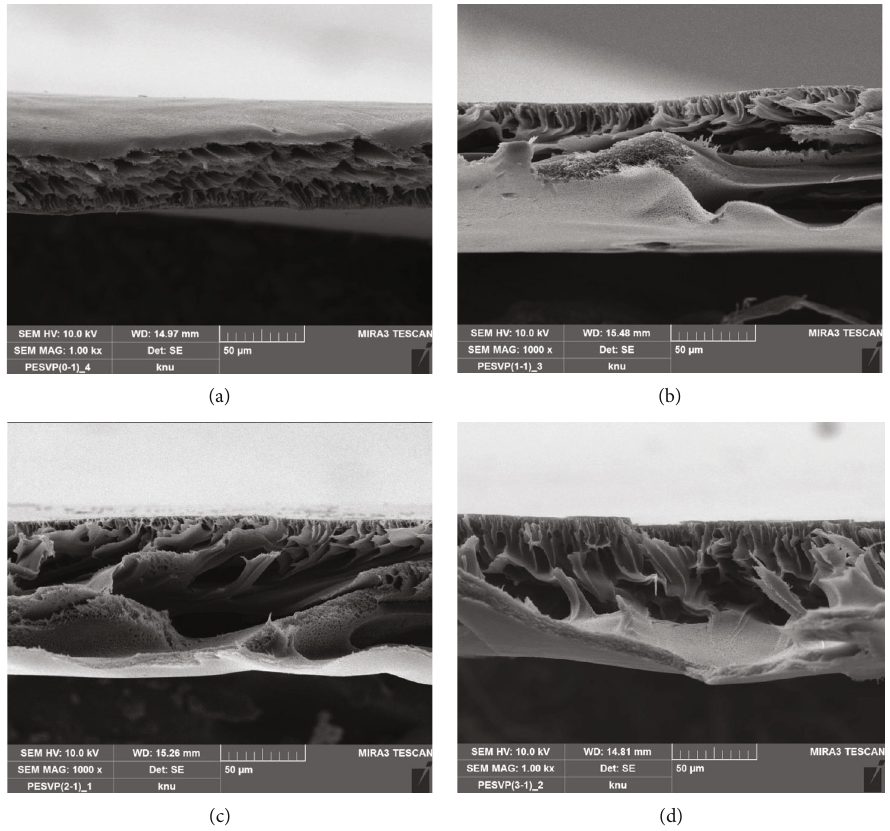
Figure 3: SEM image of PESVP membranes cross-section: (a) PESVP0-1; (b) PESVP1-1; (c) PESVP2-1; (d)